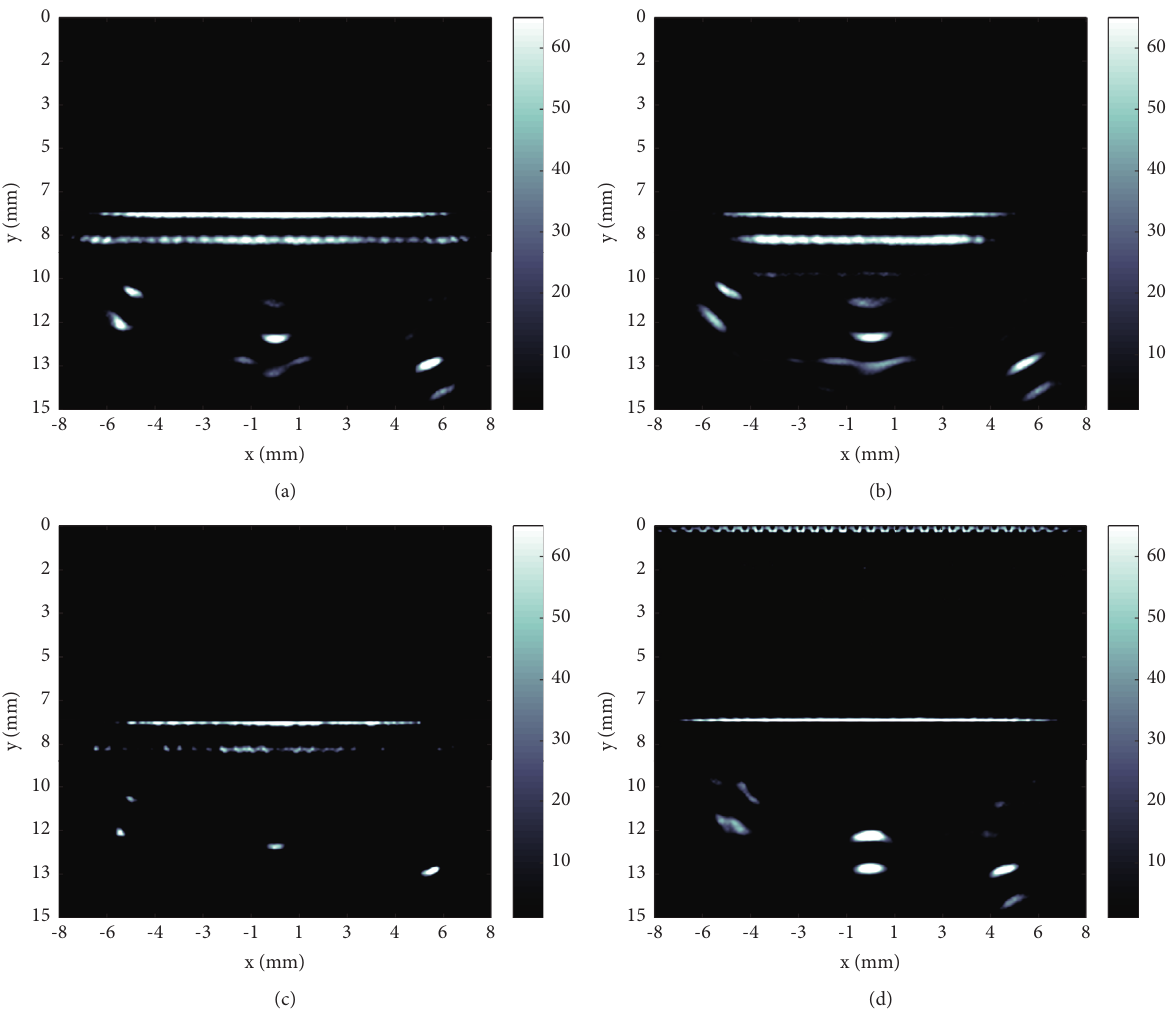
Figure 9: Focused imaging of model 3: (a) ML-TFM; (b) ML-SFM-1 (in equation (4), j � 7 : 23); (c) ML-SFM-2 (in equation (4), j � 1 : i ); (d)